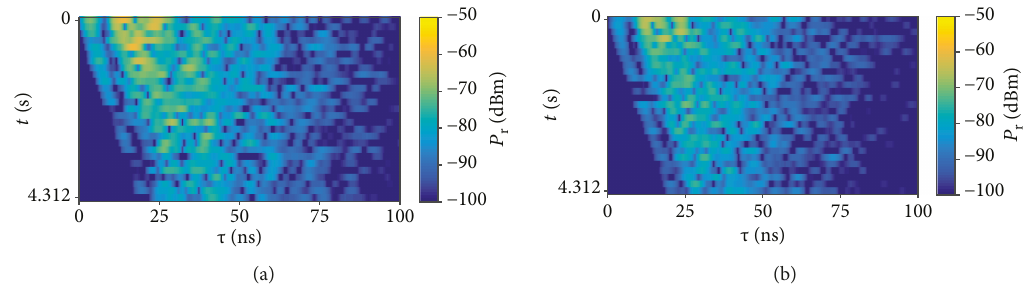
τ ) and time ( t ), for the vertically (a) and horizontally (b) polarized on-body antenna placed on TO Figure 9: Rx power ( P r ) vs. delay ( user departing